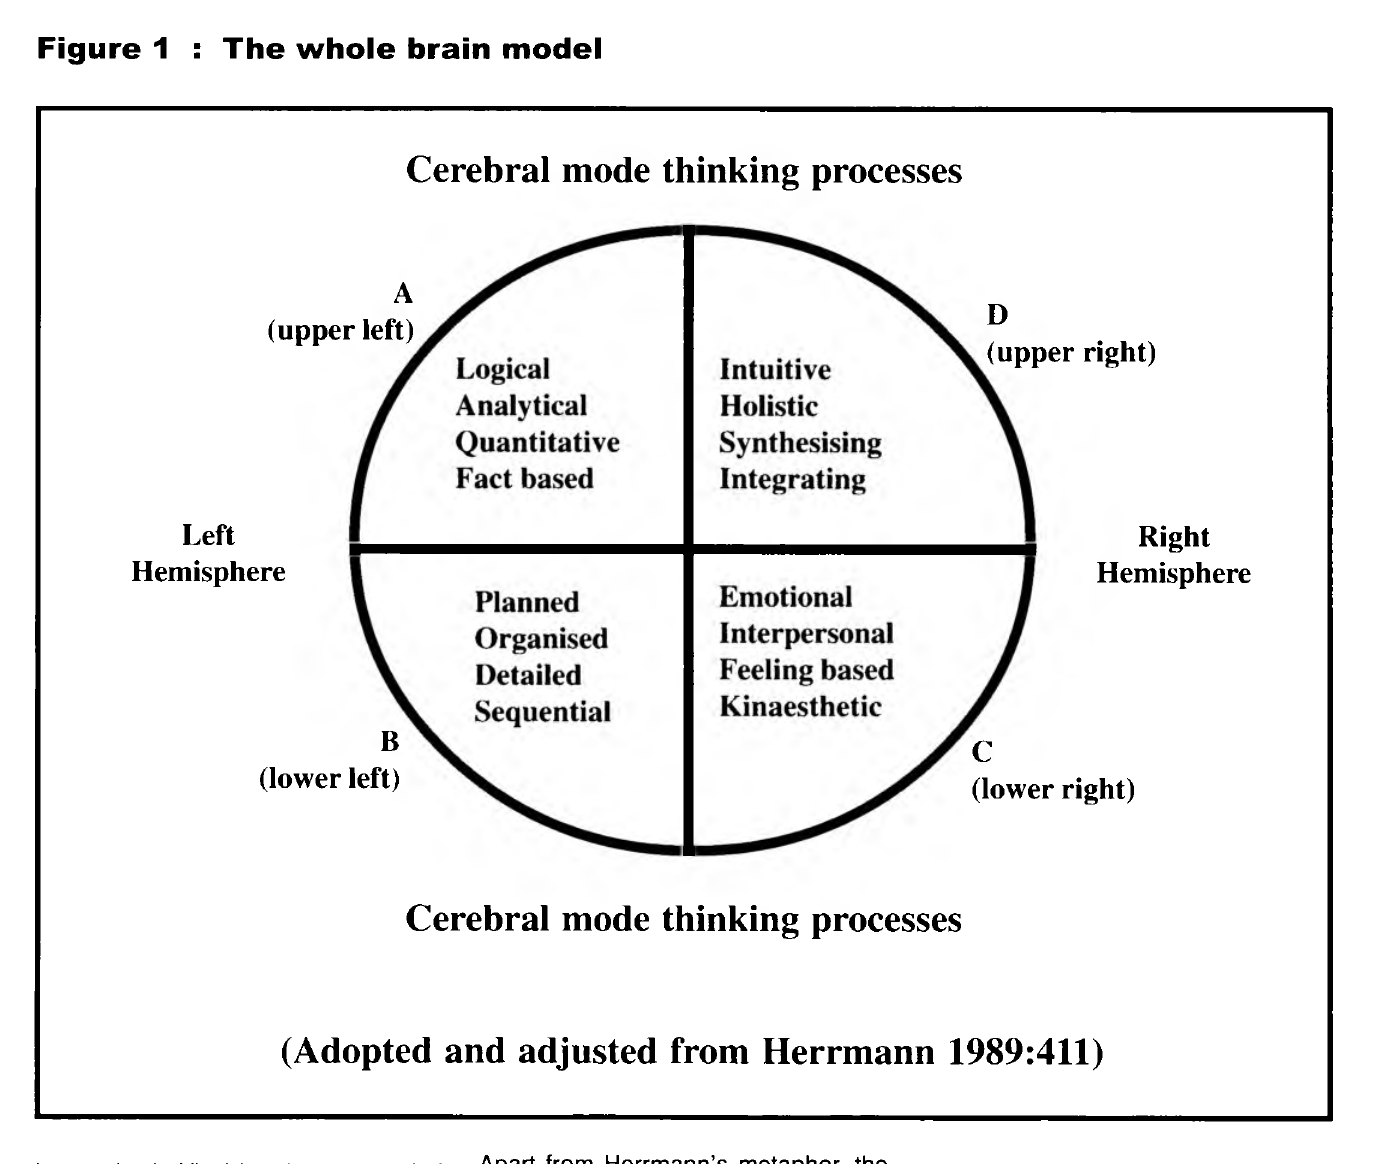
Figure 1 : The whole brain model